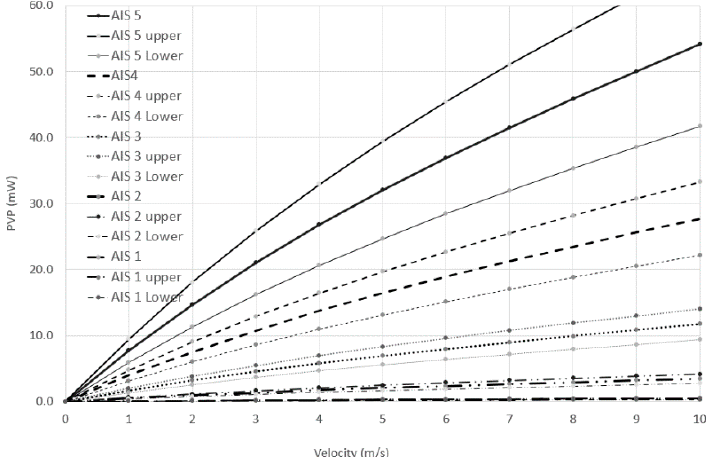
Figure 6. Organ Trauma Model–Grey matter occipital impact starting from AIS4 and then deriving the other levels [33,41].